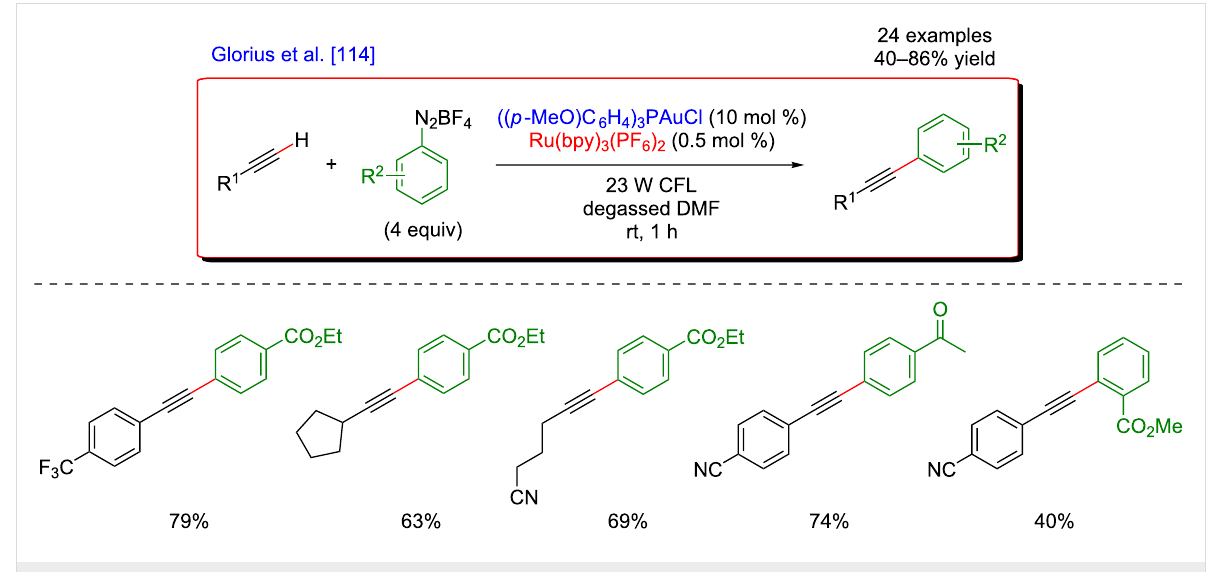
role of the latter was not fully elucidated (traces of the coupling product formed when performing the reaction in the